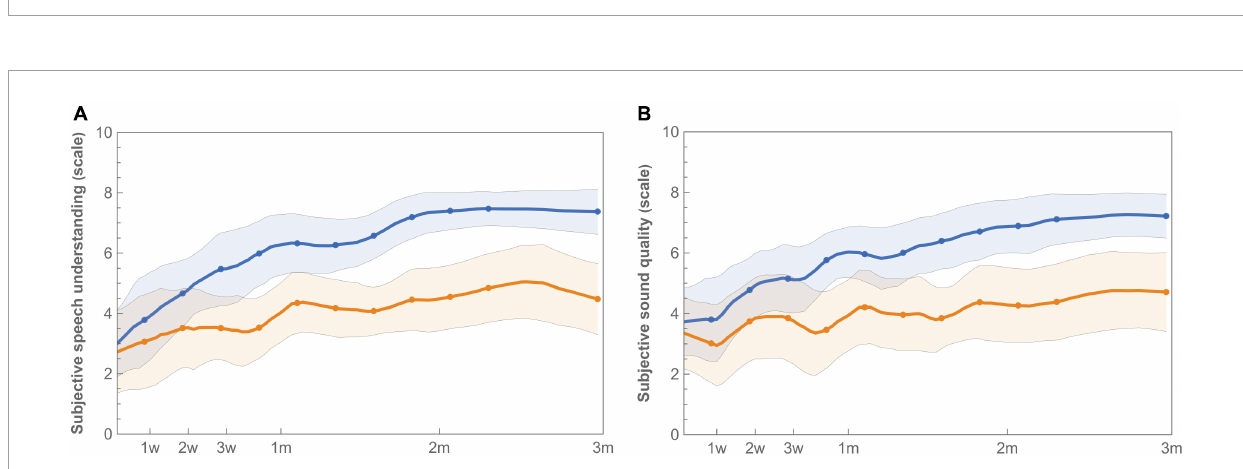
FIGURE6 Longitudinal mean satisfaction of speech understanding (A) and sound quality (B) with imaging-based (orange − ) and standard (blue − ) fitting. Ratings were performed at each visit using a 10-point satisfaction VAS scale. Error bands indicate 95% confidence intervals.